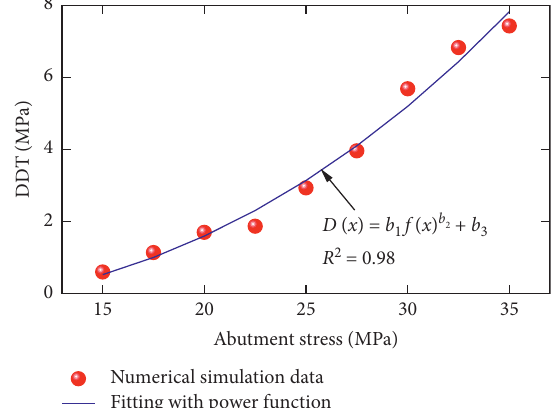
Figure 10: Relationship between DDT and abutment stress.